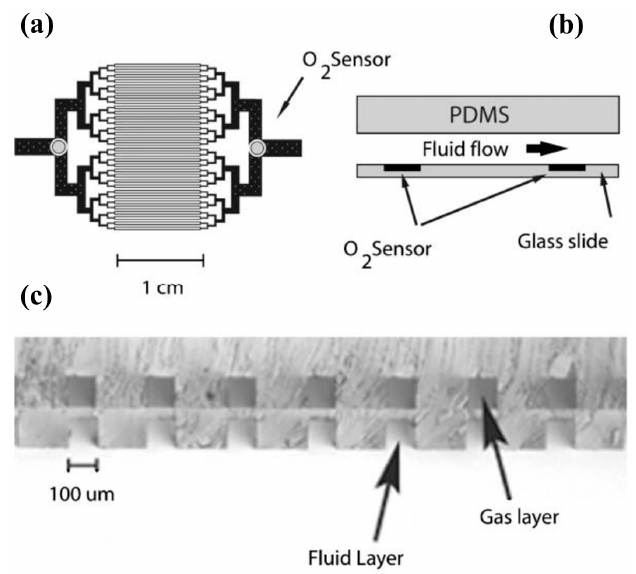
Figure 11. Schematic of the device and photo of the two layers. ( a ) Lithography mask of the capillary structure, where the circles represent the location of the O 2 sensors. ( b ) Cross section of the microfluidic device. ( c ) Vertical alignment between gas and fluid channels is noticeable in the cross-section view. The channels are separated by a 20 µ m membrane. By having a thin PDMS membrane between the two layers, di ff usion between the two phases is possible (due to the permeability of PDMS to oxygen). Reproduced with permission from [36] Copyright 2005, Royal Society of Chemistry.